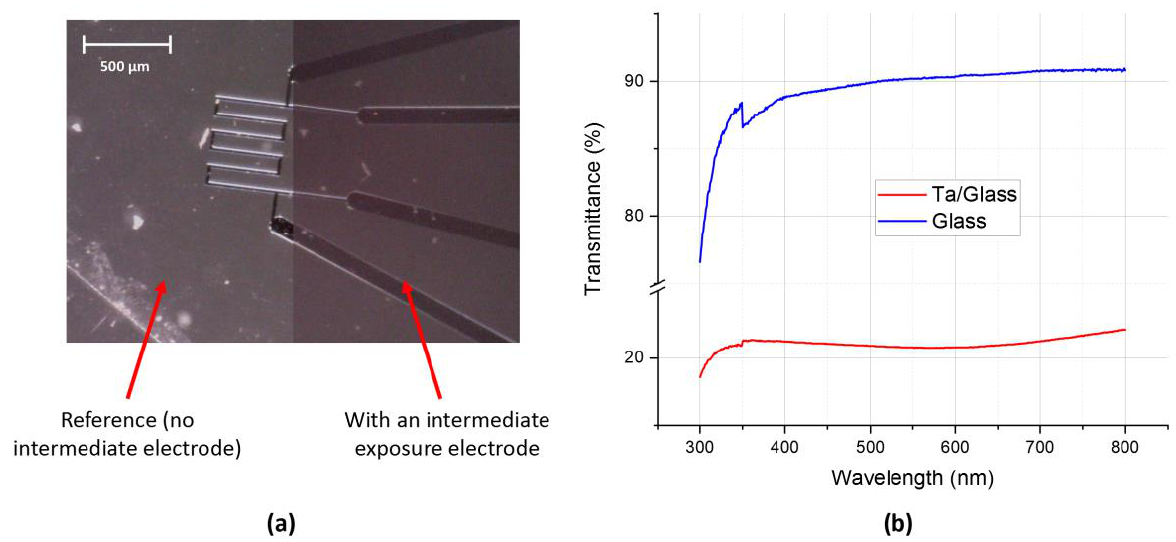
Figure 9. ( a ) Microscope observations of the thermal sensor without (left) and with (right) the transparent exposure electrode above them. ( b ) The optical transmittance spectra of the transparent exposure electrode (Ta/glass) and the glass substrate (glass).